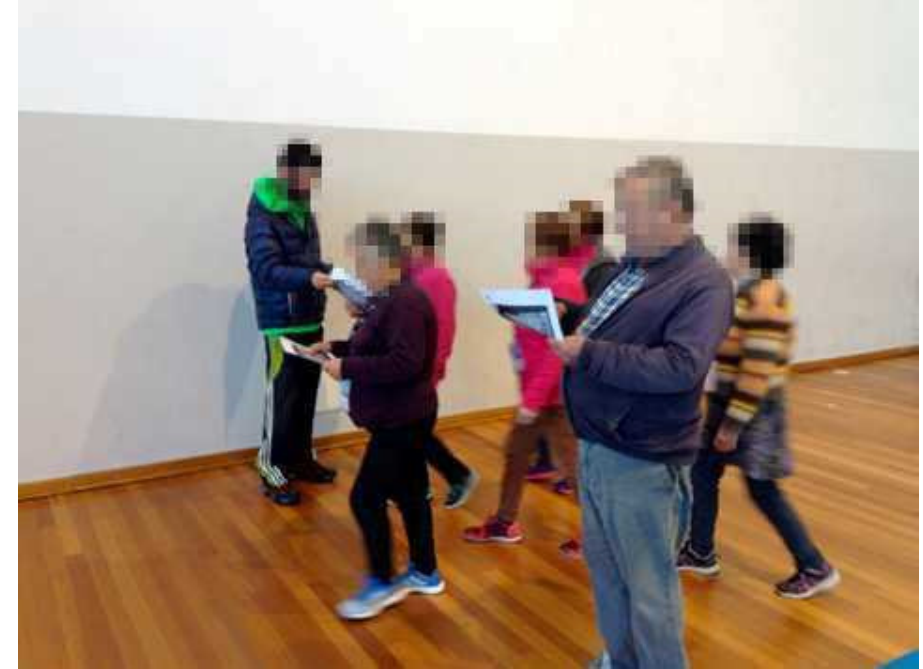
Figure 3. Food label interpretation during walking exercise. Participants were asked to select, among two, which food label had more carbohydrate, added sugar, fat, or saturated fat.